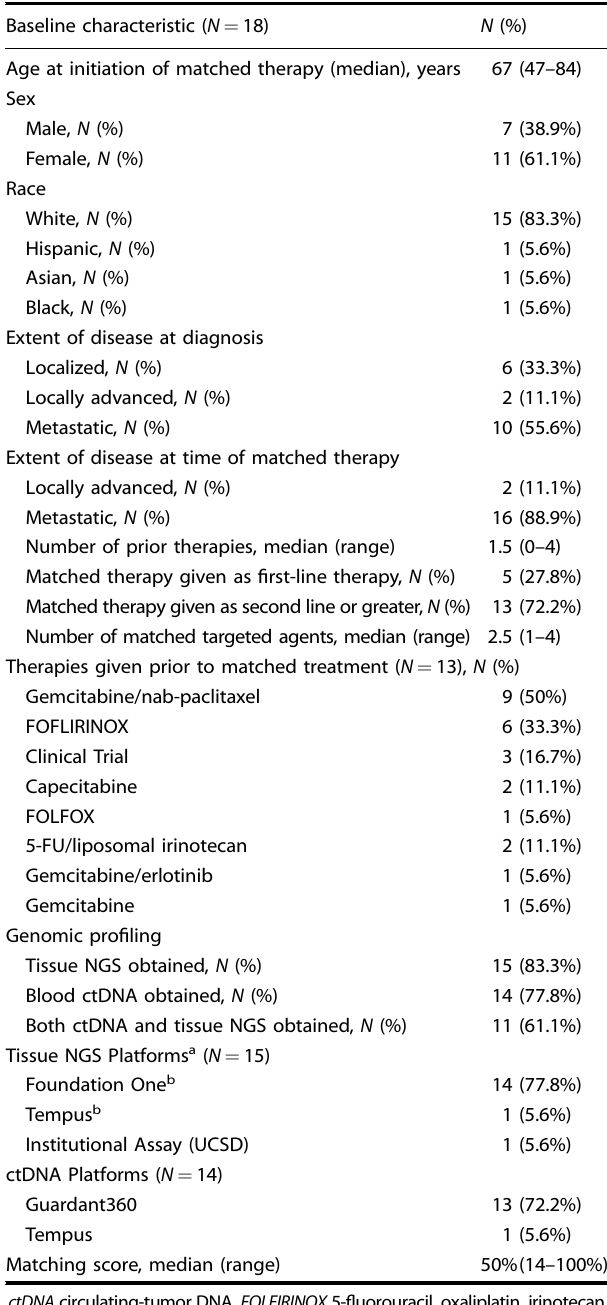
Table 1. Patient demographics and genomic